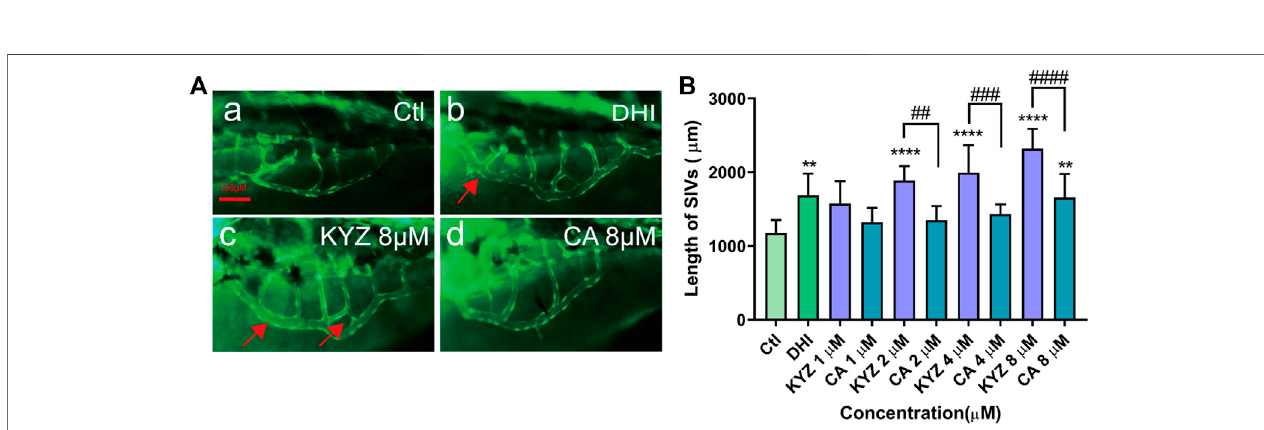
FIGURE 4 | KYZ and CA treatment promoted SIVs growth in zebra fi sh. (A) The red arrow indicates cross-linking and budding of SIVs. The 48 hpf zebra fi sh embryos were treated with KYZ and CA at concentrations of 1, 2, 4, 8 μ M for 24 h, and the result showed that there was a growth of SIVs observed. DHI was used as a positive control. Scale bar is 100 μ m. (B) Quantitative analysis of the total length of the SIVs in zebra fi sh after treatment with KYZ, the data were expressed as mean ± SEM.One-wayANOVAwasusedforstatisticalanalysis( n =12).** p < 0.05,**** p < 0.0001vs.controlgroup.## p < 0.01,### p < 0.001,#### p < 0.0001,KYZvsCA.